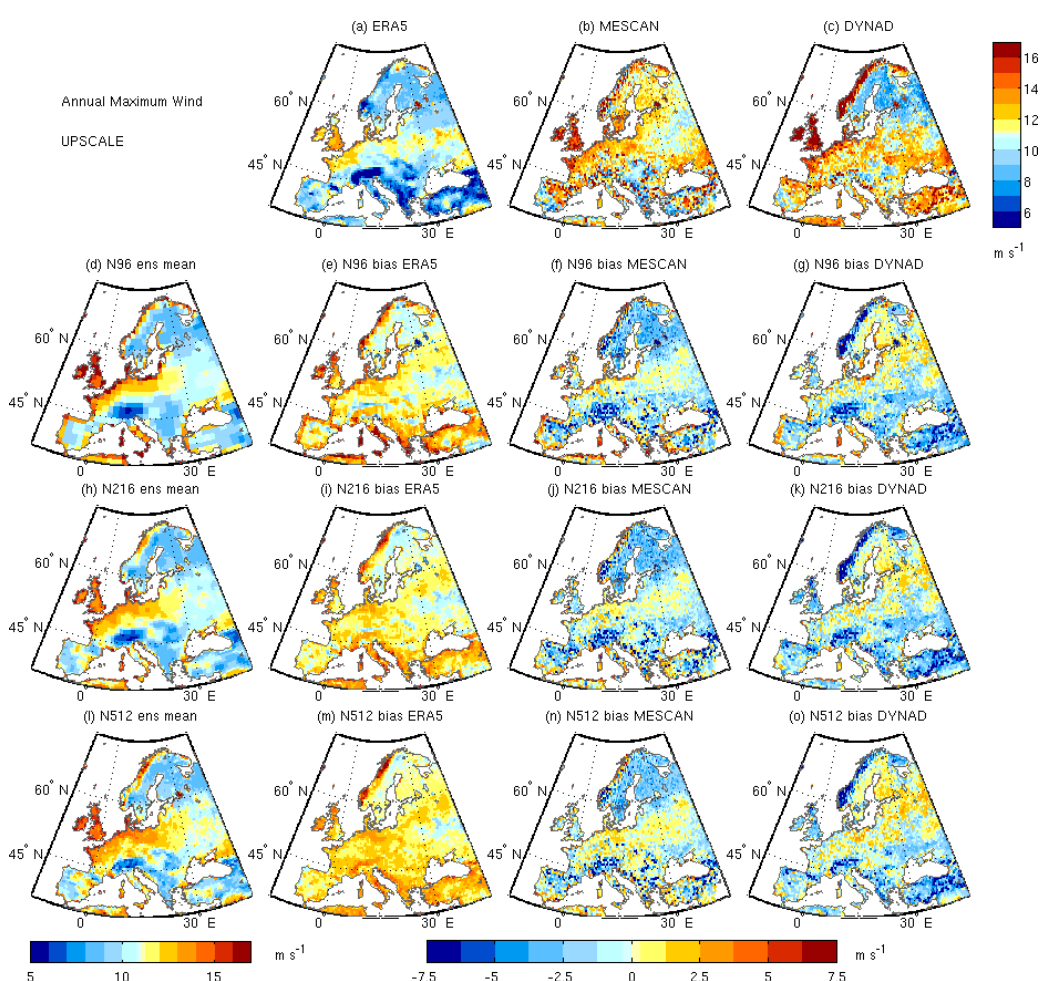
Figure 8. Climatological mean of annual maximum wind for the ensemble means of three resolutions of UPSCALE (left) simulations for the period 1986–2011 and their biases with respect to the observational datasets ERA5 (left column), MESCAN (middle), and MESAN (right). (a) ERA5, (b) MESCAN, (c) DYNAD, (d–g) N96, (h–k) N216, and (l–o) N512. Units: metres per